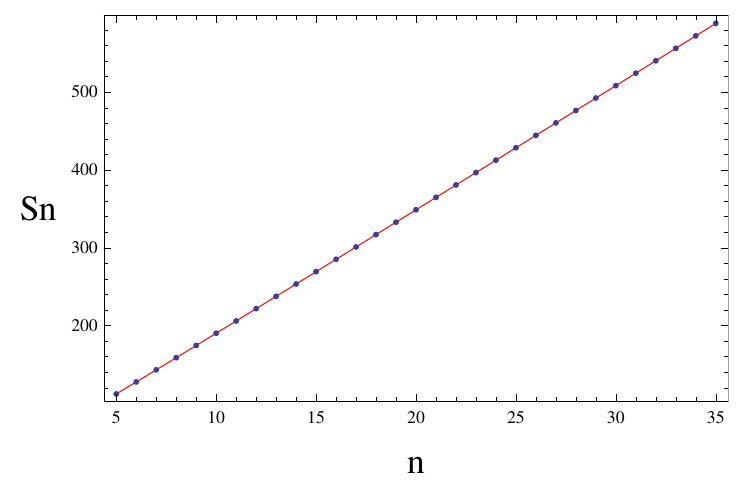
Figure 18 . The entanglement entropy of gauge (cid:12)eld with ~ A center.